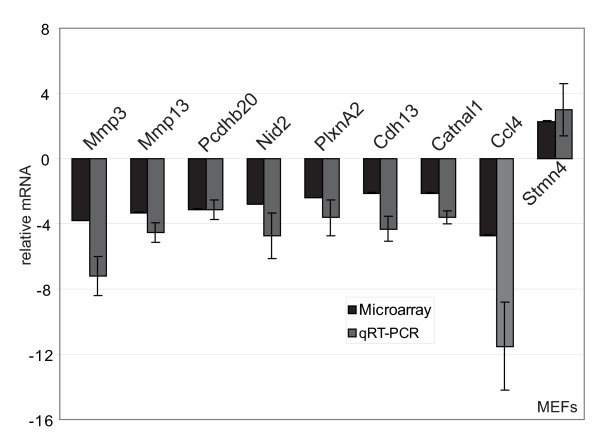
Microarray analysis validation for mouse embryo fibroblasts (MEFs). Microarray data (Additional file 2) were validated by quantitative real-time polymerase chain reaction (qRT-PCR) for nine genes on RNA extracted from three independent AP-2α +/- or -/- mouse embryo fibroblast (MEF) preparations. The 18S rRNA or GAPDH housekeeping genes were used as internal controls to normalize the data. qRT-PCRs were performed in triplicate on all different RNA preparations. Microarray analysis and qRT-PCR fold changes are shown for each validated gene as average values. Bars represent ± standard deviations.